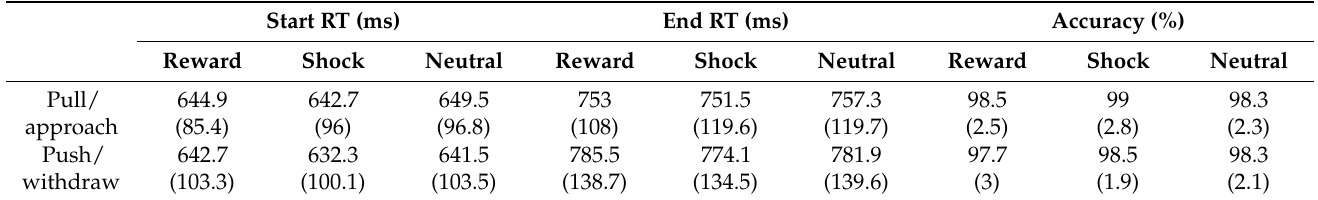
Table 2. Mean start RT, end RT and accuracy as a function of distractor type and response direction in the test phase of Experiment 1. Numbers in the parentheses represent the standard